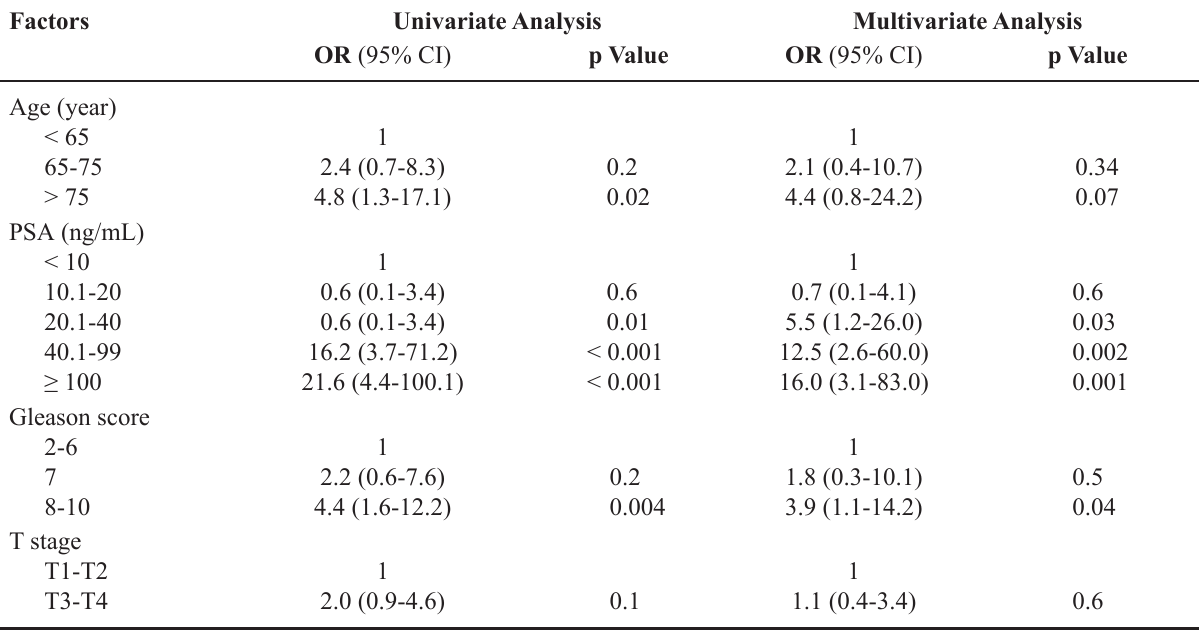
Table 3 – Analysis of independent factors (age, PSA, Gleason score, clinical T stage) predictive of positive bone metastasis on bone isotope